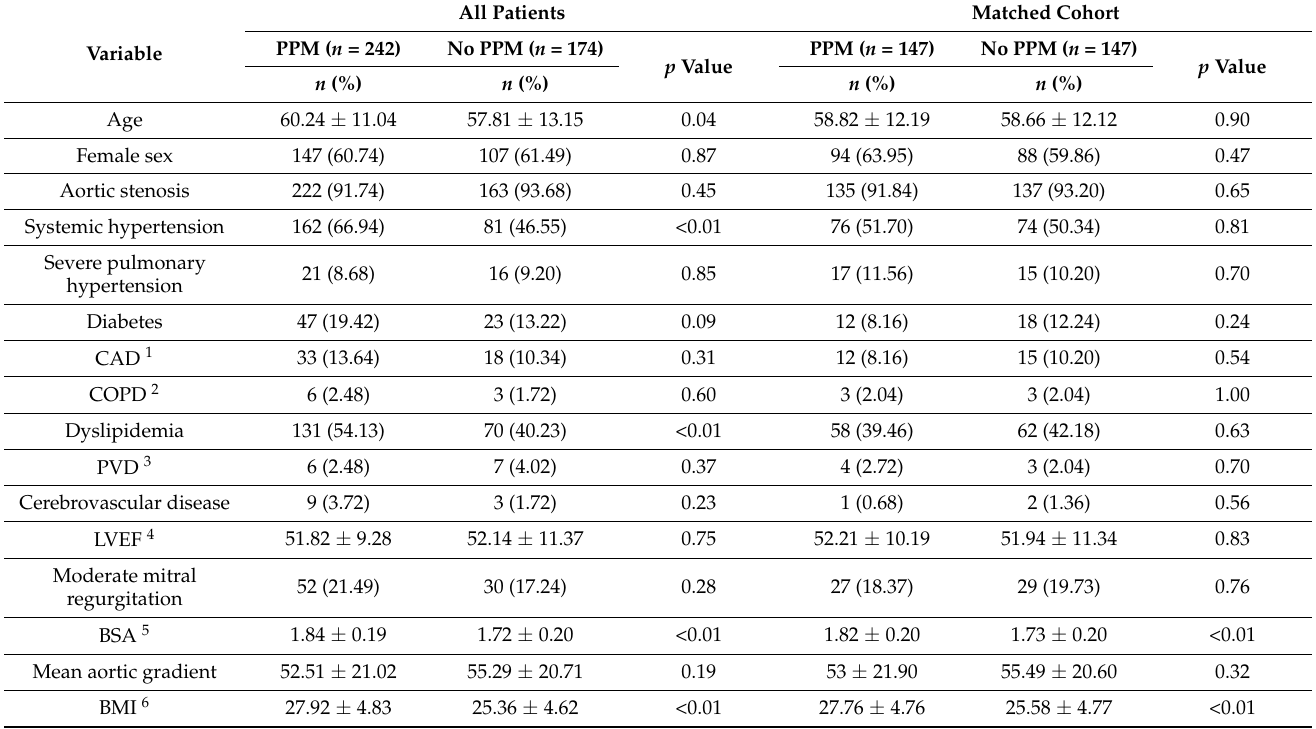
Table 1. Baseline characteristics of the study cohort.